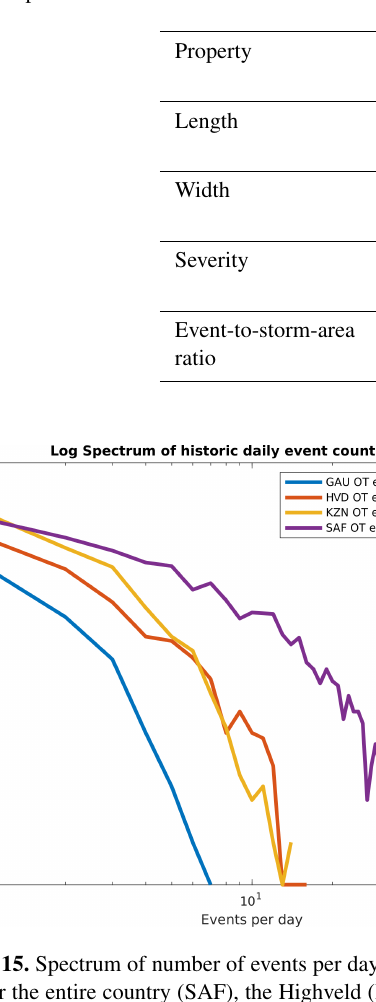
Table 2. Spearman rank correlation matrix of historic OT event properties.